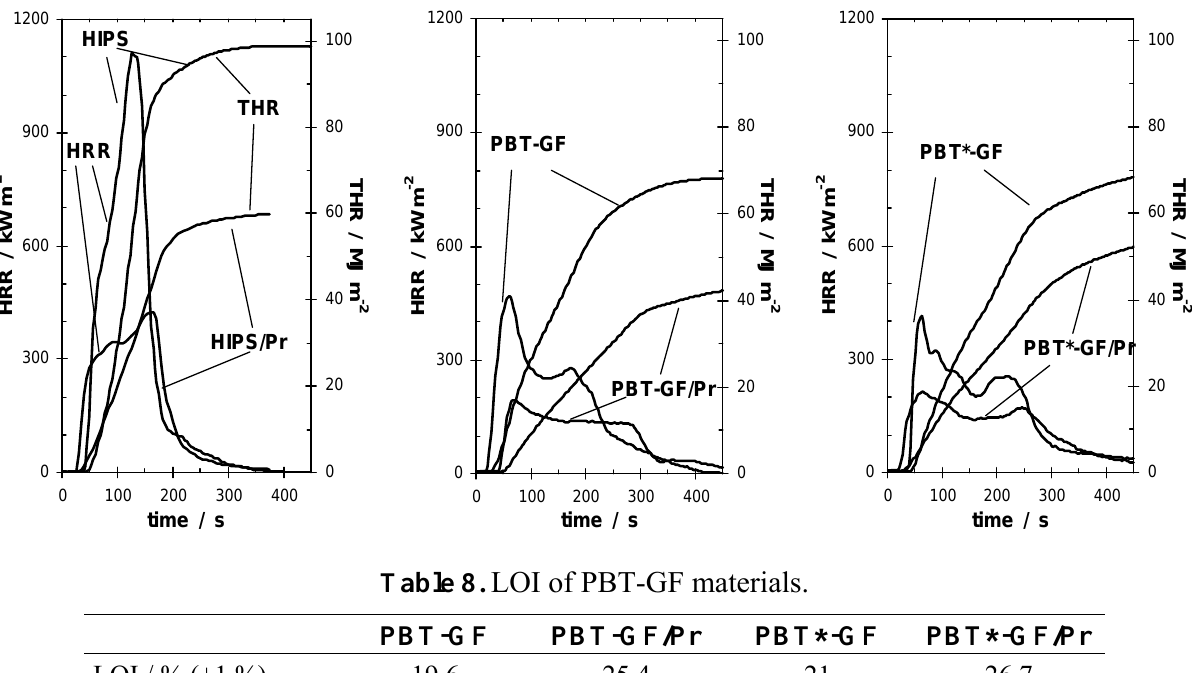
Figure 8. Cone calorimeter results (HRR and THR; irradiance = 50 kW m –2 ) for HIPS and HIPS/Pr (left), PBT-GF and PBT-GF/Pr (middle), PBT*-GF and PBT*-GF/Pr (right). Pr reduces PHRR and THE through flame inhibition.